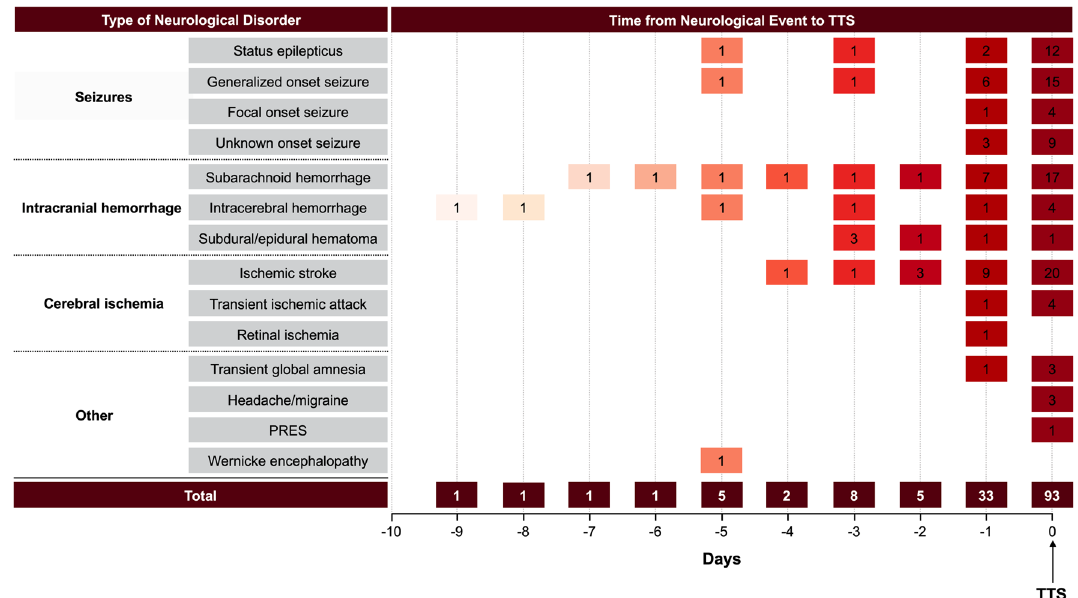
Figure 2. Time link between neurological disorders and takotsubo syndrome. Of the 150 patients included in the analysis median time from neurological disorders to TTS was 0 (IQR 0–1) days. Notably, time from neurological disorder to TTS was less than 2 days in 87.3% of cases. In 62% of cases the neurologic event and TTS were diagnosed on the same day, while 38% of patients were already hospitalized for the underlying neurologic conditions and TTS diagnosed during the clinical course. Numbers in boxes are the number of patients diagnosed with neurological disorders on the respective day. X-axis: days from neurological event to TTS. Y-axis: different types of neurological disorders triggering TTS. 7 patients with overlap of 2 acute neurological conditions and were excluded (2 with focal onset seizure and ischemic stroke, 2 with generalized onset seizure and PRES, 1 with status epilepticus and PRES, 1 with status epilepticus and SAH, and 1 with generalized onset seizure and SAH). In 4 cases the exact time of onset of neurological disorders was unknown (1 patient with subarachnoid hemorrhage, 1 patient with ischemic stroke, 1 patient with unknown onset seizure, and 1 patient with left frontal lobe tumor with progressive aphasia). IQR Interquartile range, PRES Posterior reversible encephalopathy syndrome, SAH Subarachnoid hemorrhage, TTS Takotsubo